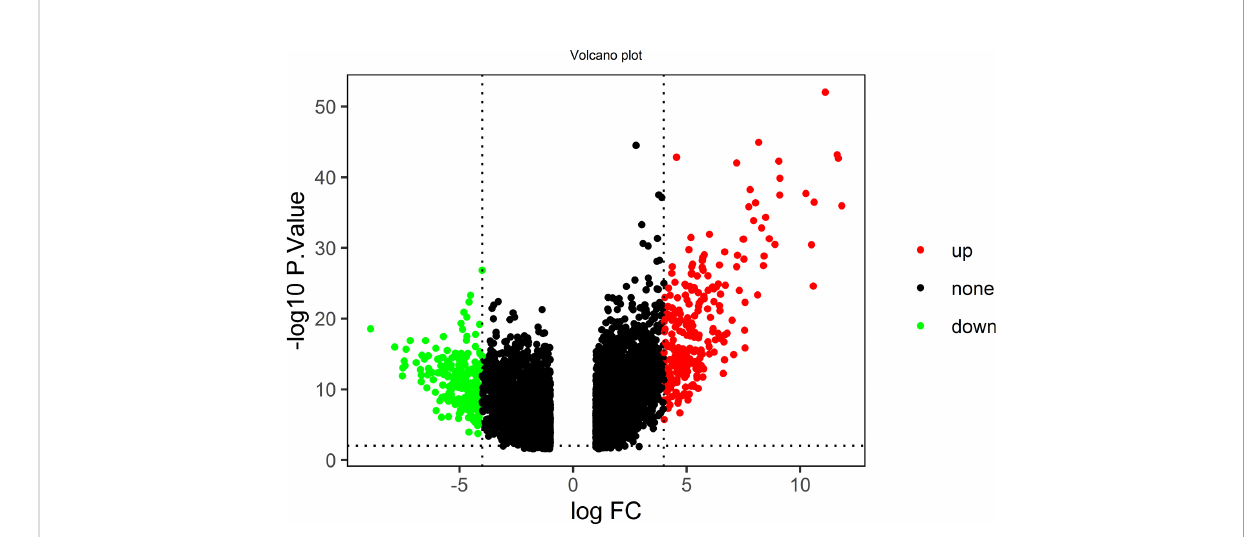
( p < 0.01) and |log 2 Fc| > 4. Red dots represent upregulated genes, and green dots represent downregulated genes. Then, based on the cutoff criteria ( p < 0.01 and |log2 Fc| > 4), a total